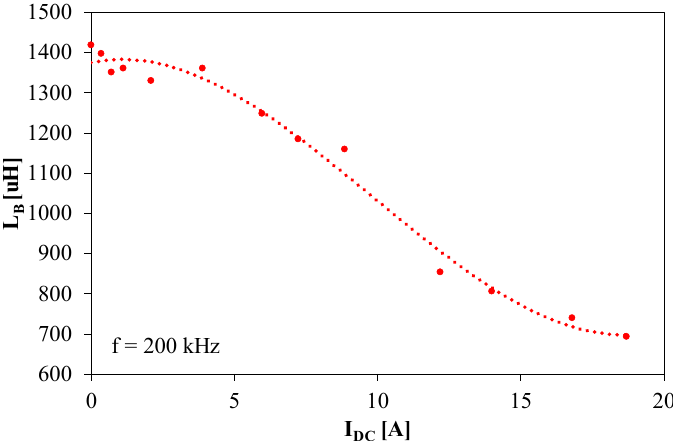
Figure 6. Dependence of the blocking inductance L B of a blocking inductor on the direct current I DC.